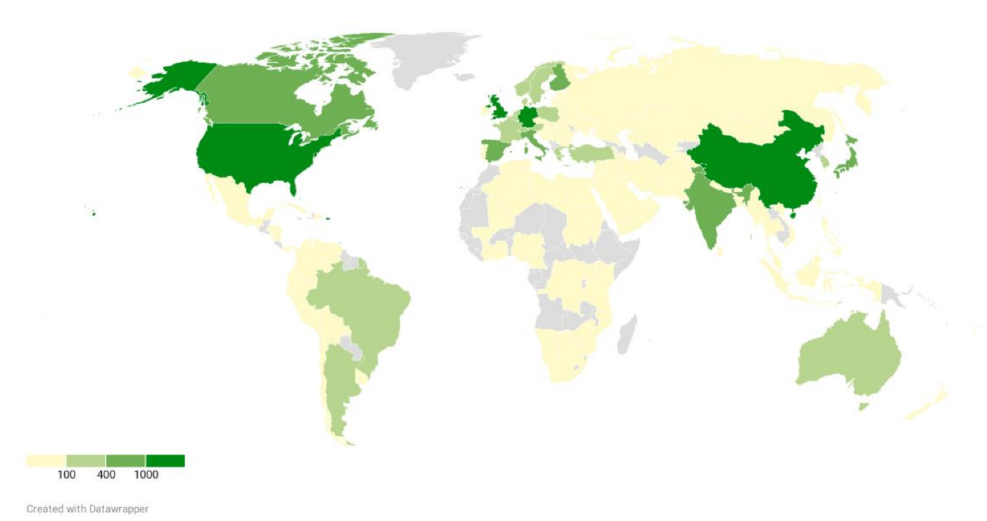
Figure 3. Contribution by country to research documents on ozone in the plant field in the period